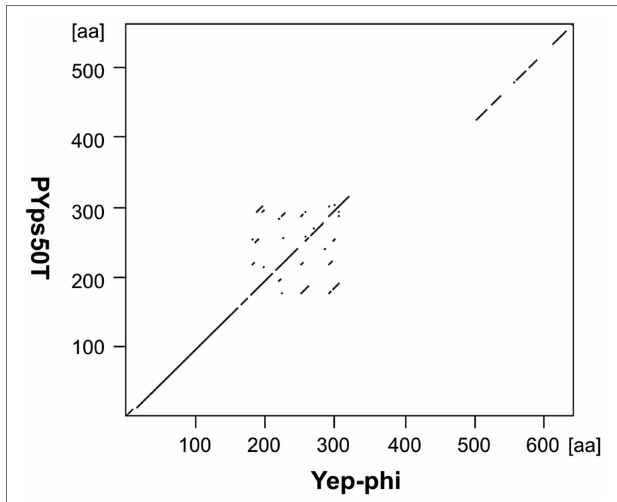
FIGURE 6 | Dot plot of the tail fiber proteins of PYps50T and Yep-phi. Dot plot analyses were conducted using Accelrys DS Gene (version 2.5; Accelrys Inc.) with the following settings: minimum sequence identity: 65%; window size: 15; and hash value: